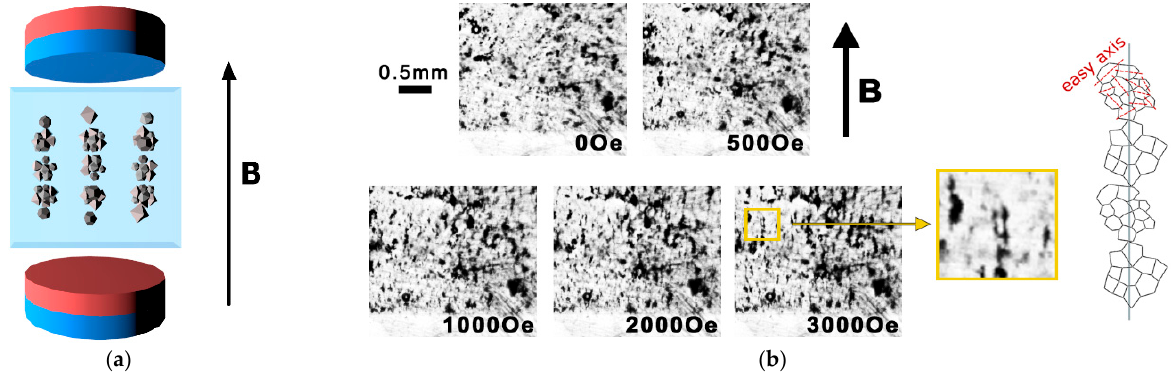
Figure 1. ( a ) Illustration of the alignment of CFO NPs in PVDF polymer in a magnetic field; ( b ) optical image of the formation of ordered chains of CFO NPs clusters in the liquid precursor of PVDF-TrFE polymer under external magnetic fields of different inductions. The sketch represents a structure of the chain as an elongated assembly of NPs clusters with the random distribution of easy axes of individual particles inside each cluster (red lines).